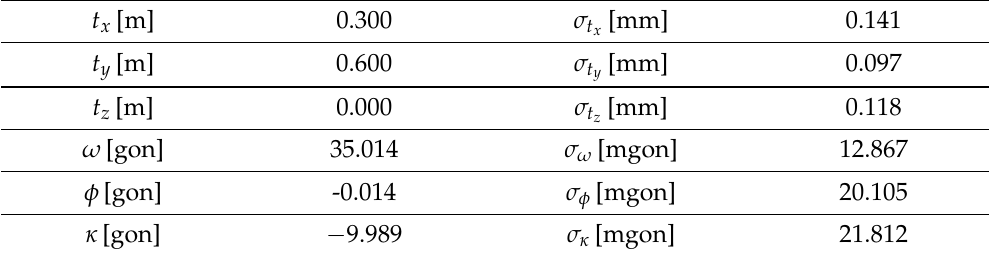
Table 8. Results of the estimated rigid body movement after having extended S CS (data set V40, a = 1, n CS , val = 7, n CS , ex = 7)